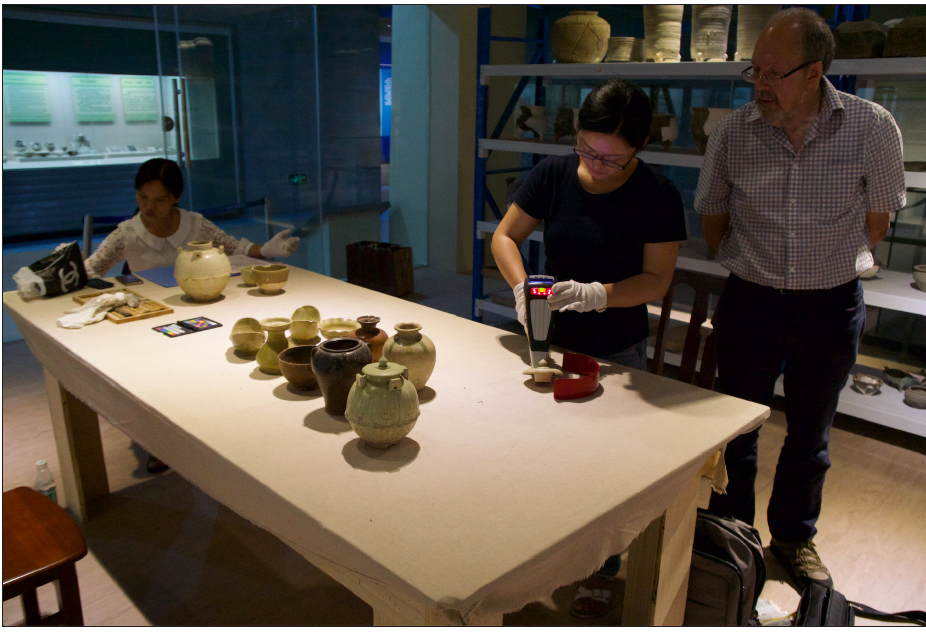
Figure 2: Analysing ceramic samples with pXRF at Anyang Museum in Henan Province (Photo Lihua